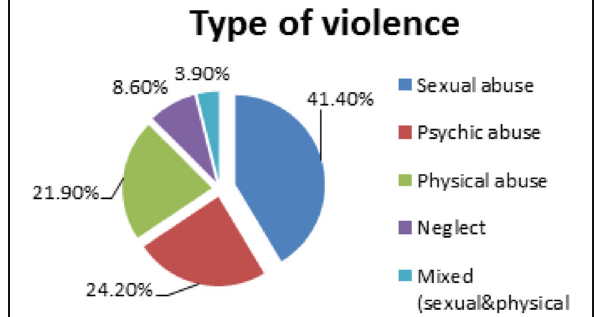
Fig. 4 Distribution of studied cases according to type of